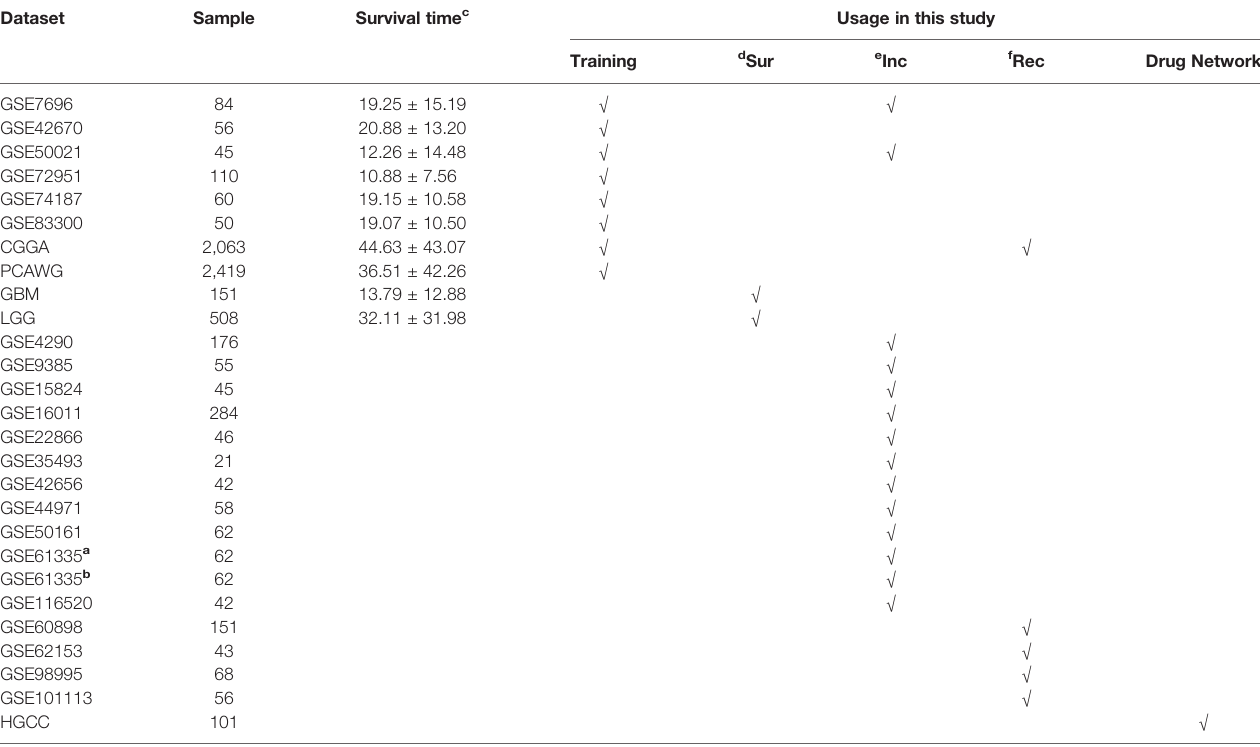
TABLE 1 | The information of all datasets used in this article.